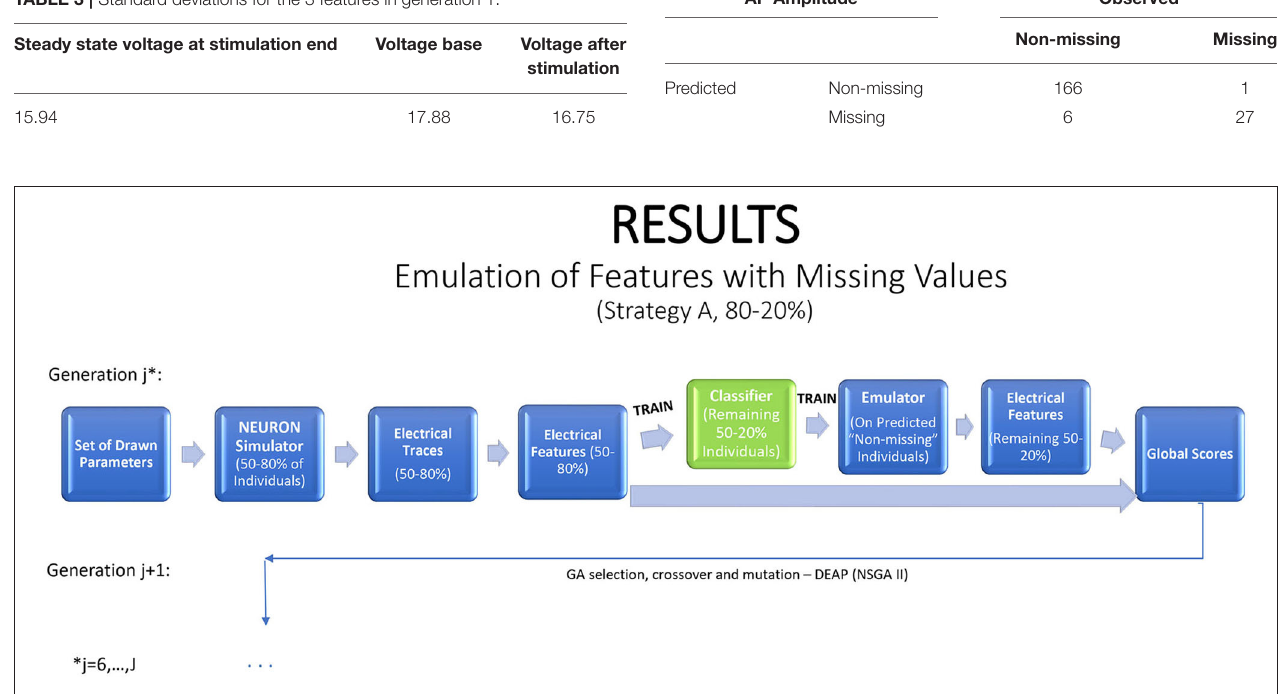
TABLE 3 | Standard deviations for the 3 features in generation 1.